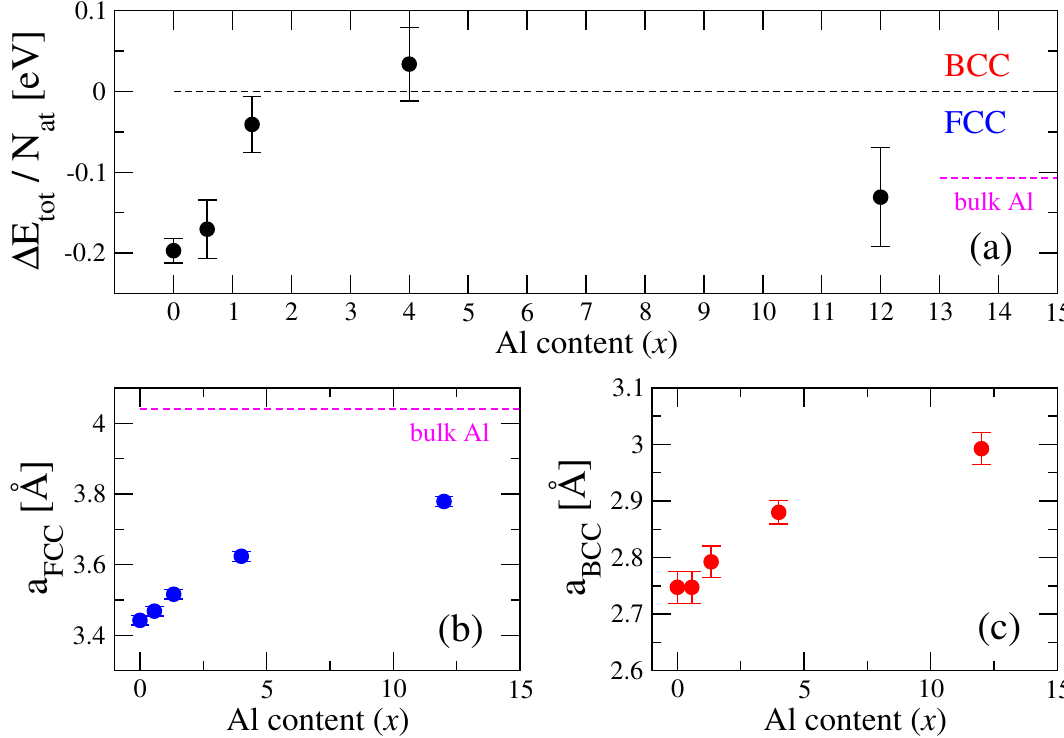
Figure 2. ( a ) Total energy difference between the FCC and BCC configurations per atom, ∆ E tot / N at ( N at = 32), as a function of Al content x , indicating the equilibrium phase. The variation of the equilibrium lattice constant with the Al content x for FCC ( b ) and BCC ( c ). The experimental value for bulk Al ( x → ∞ ) is shown for